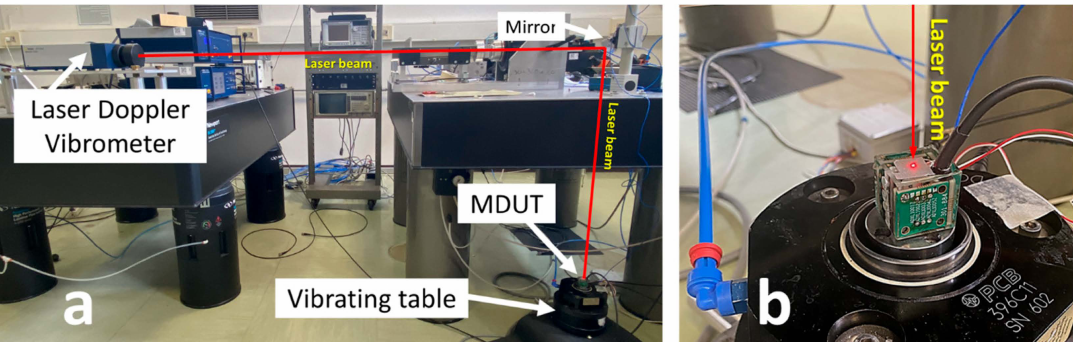
Figure 12. Characterization of the mechanical behavior of the embedding resin case during MDUT calibration in dynamic conditions: ( a ) the whole measuring system and ( b ) the MDUT on the vibrating table hit by the single-point Laser-Doppler vibrometer beam on the upper surface.